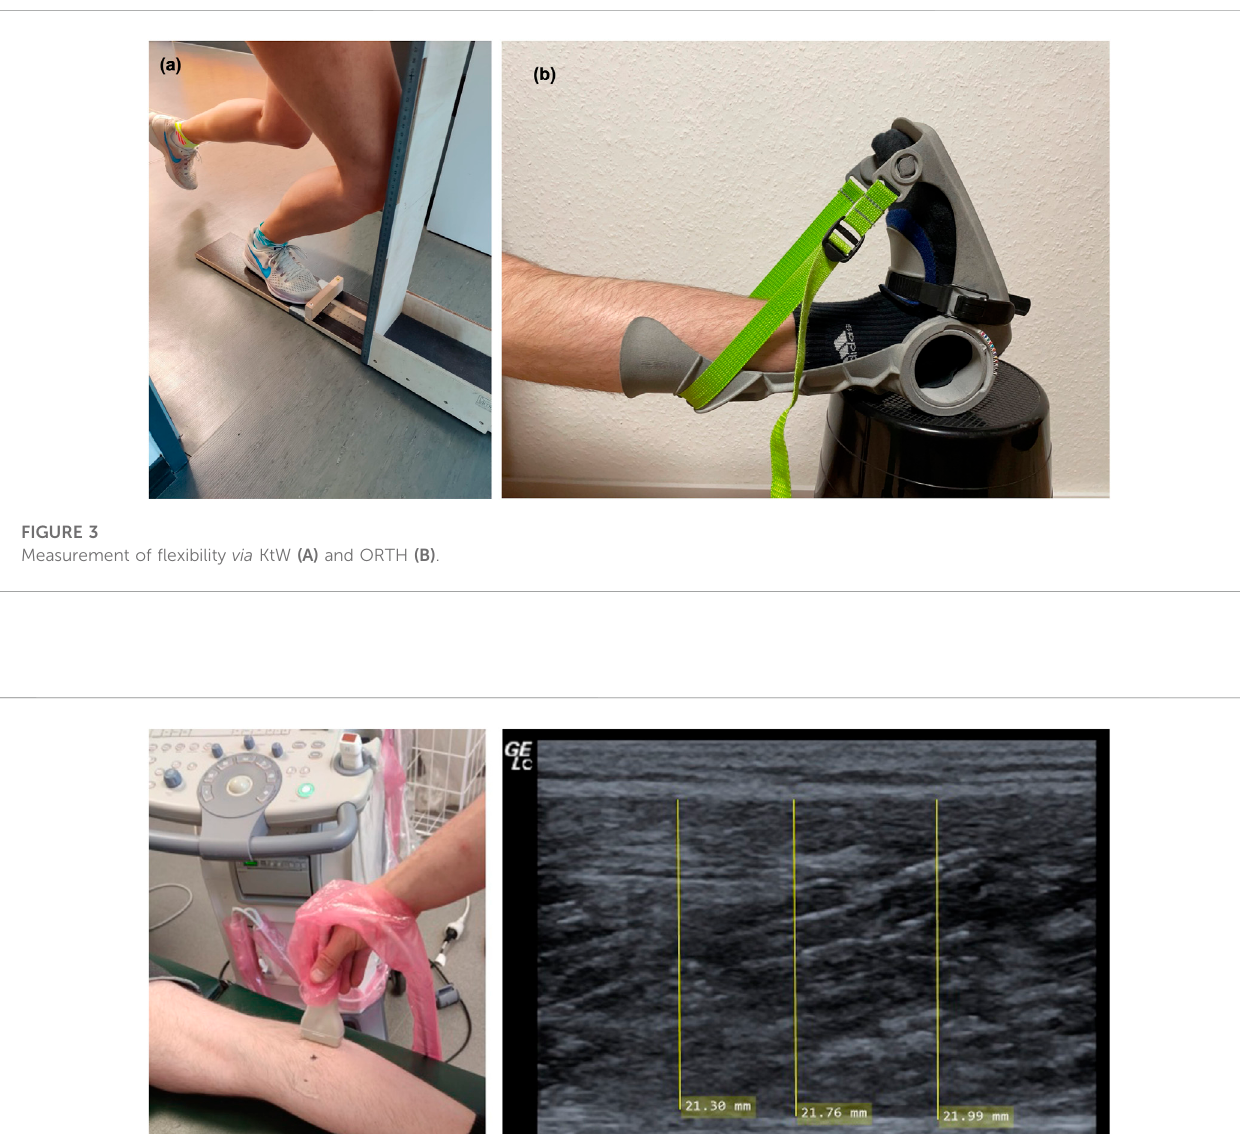
the plantar fl exors. The set angle of the orthosis as well as the time of daily stretch was documented by the participants in a stretching log. They were instructed to reach an individual stretching pain of 7-8 on a visual analogue scale of 1 – 10 (with 0 = no pain; 10 = maximum point